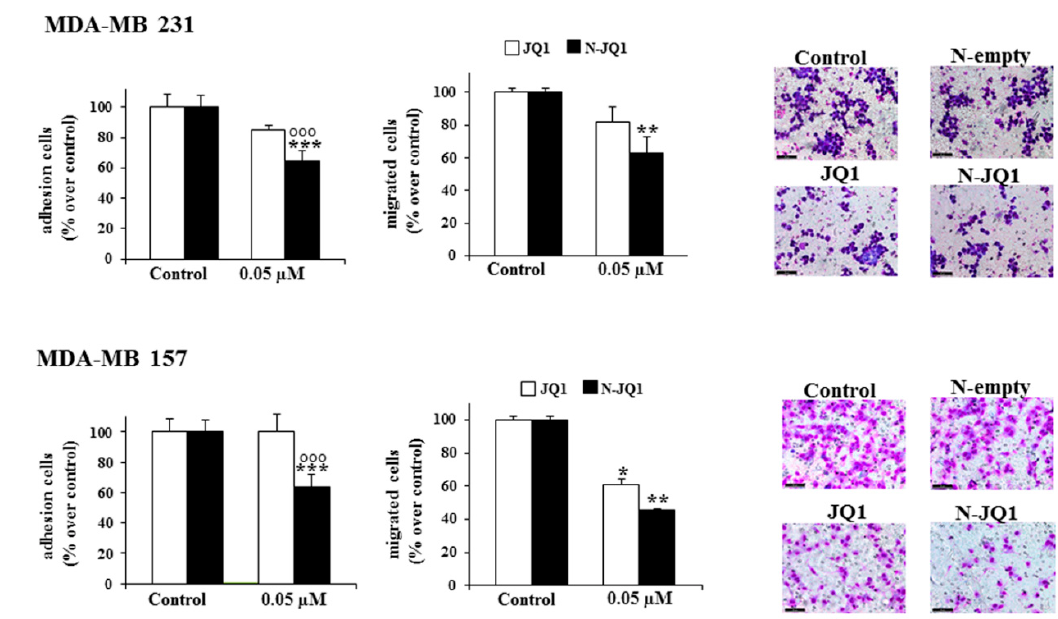
Figure 3. Effects of N-JQ1 on adhesion and migration properties of TNBC. MDA-MB 231 and MD-MB 157 cells were prepared for adhesion and migration assays as indicated in methods. Each experiment was performed in triplicate and values are expressed in % over Control, as means ± SD. Statistical analysis was performed using the one-way ANOVA test. * p < 0.05, ** p < 0.01, *** p < 0.001 vs. Control; ◦◦◦ p < 0.001 vs. JQ1. Representative images of stained cells after migration assays are shown. Control, cells treated with JQ1 vehicle (white bars) or empty nanoparticles (black bars). Scale bar: 50 µ